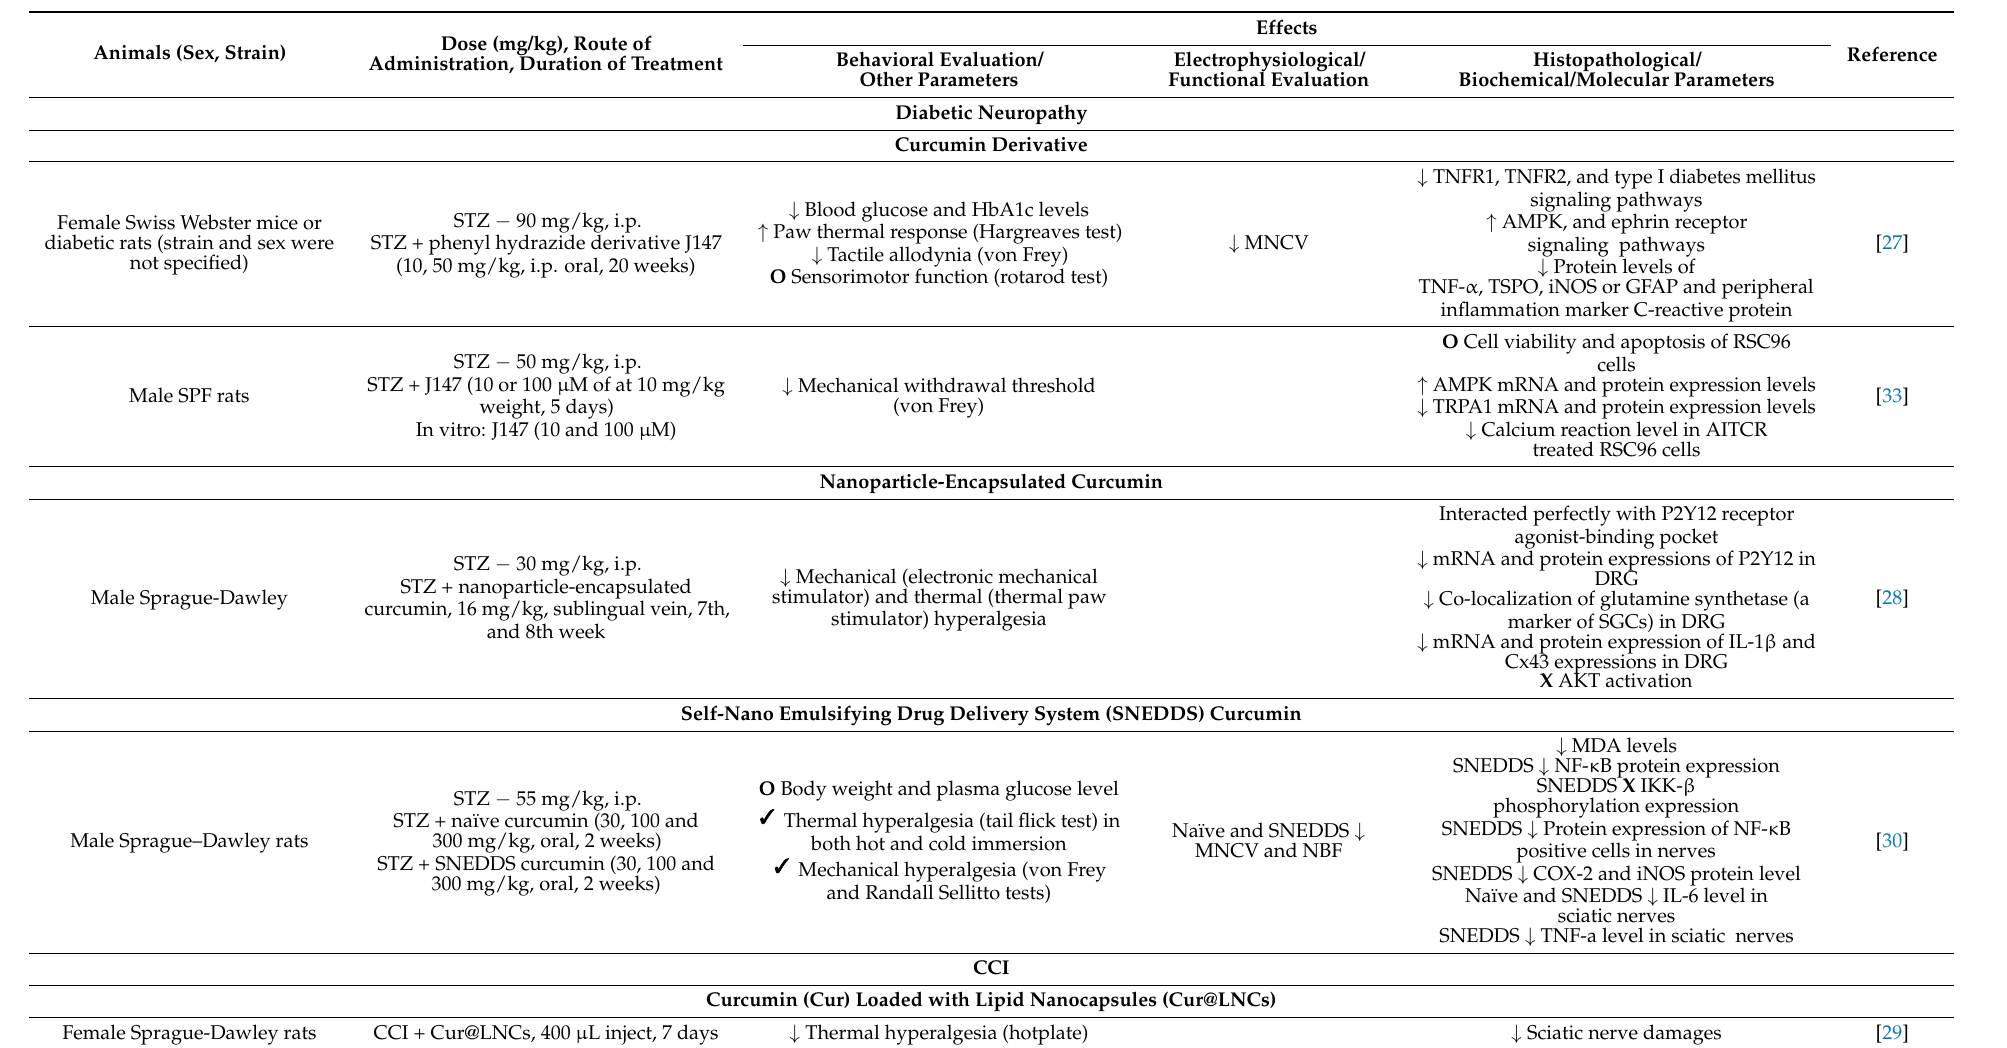
Table 6. Effects of different curcumin formulations on neuropathic pain.